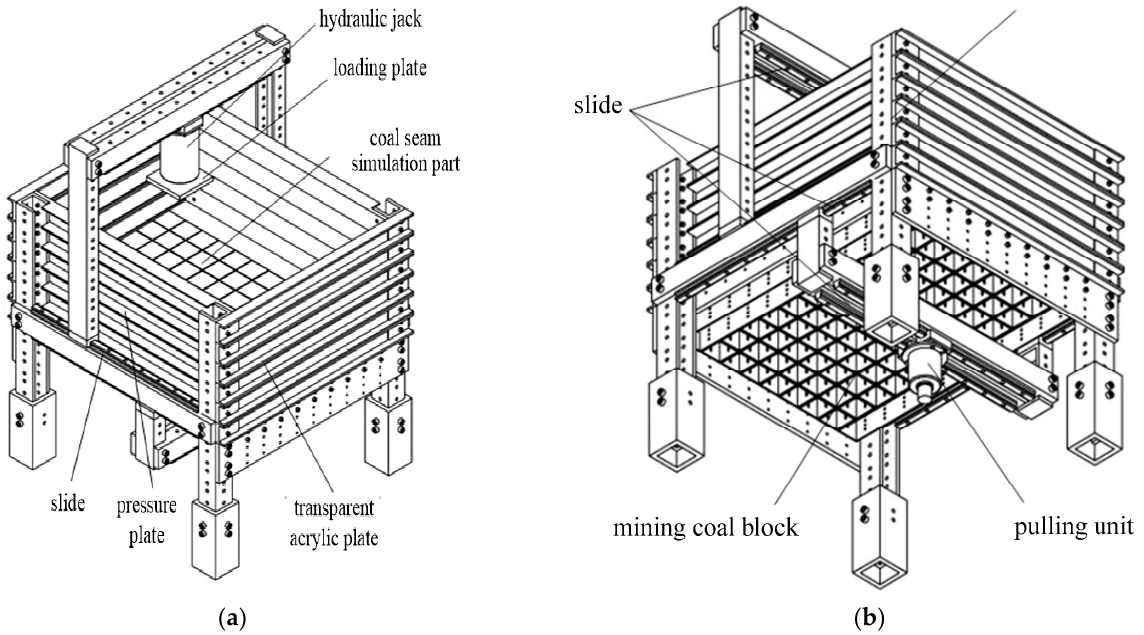
Figure 1. Schematic diagram of the device structure: ( a ) the top structure and components of the device; ( b ) bottom structure and components of the device.